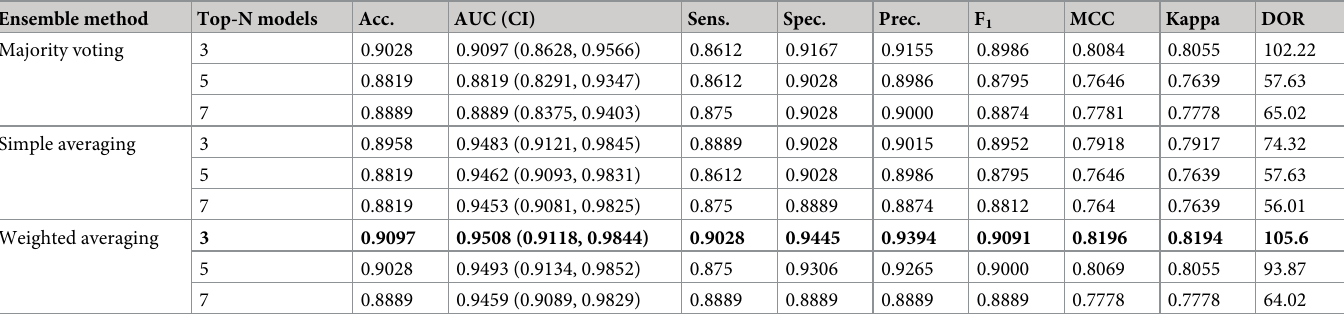
Table 7. Performance achieved with an ensemble of top-3, top-5, and top-7 fine-tuned models toward COVID-19 detection. Ensemble method Top-N